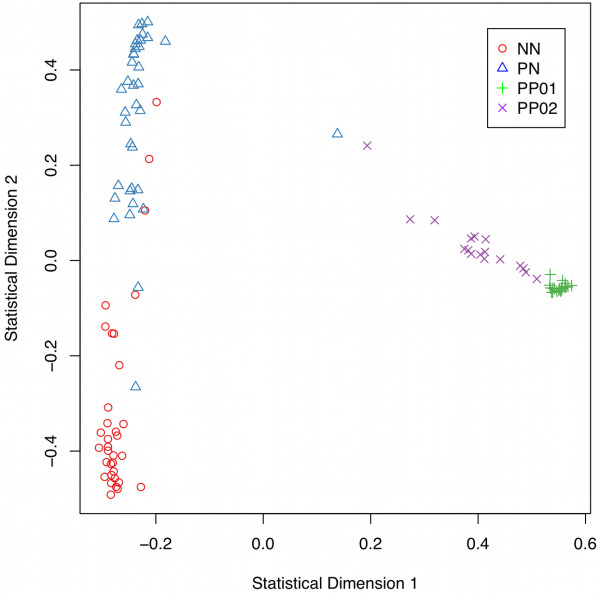
A multidimensional scaling (MDS) plot to illustrate the molecular grouping of samples. A dissimilarity matrix in random forest is constructed through the use of synthetic data drawn from the distribution of psoriatic samples (see Methods). Patients are clustered according to these dissimilarities and two distinct psoriatic groups are identified, PP01 (green) and PP02 (purple). All lesional samples (PP) cluster away from both normal (NN) and non-lesional (PN) tissue samples, in accordance to observations in figure 2c.